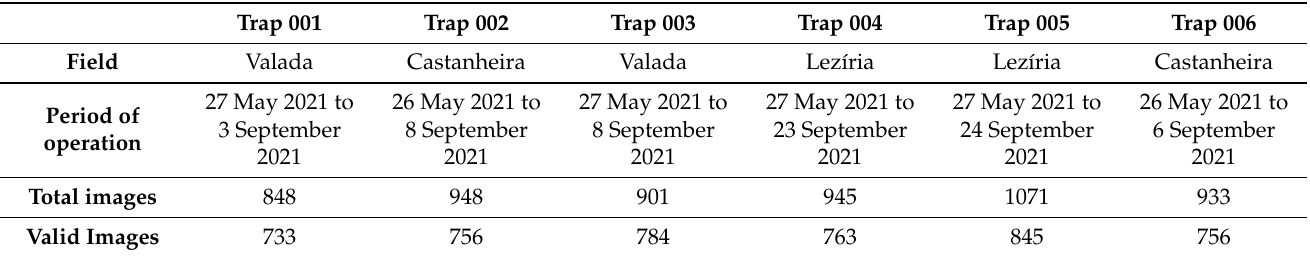
Table 2. Data on the insect trap images where data were